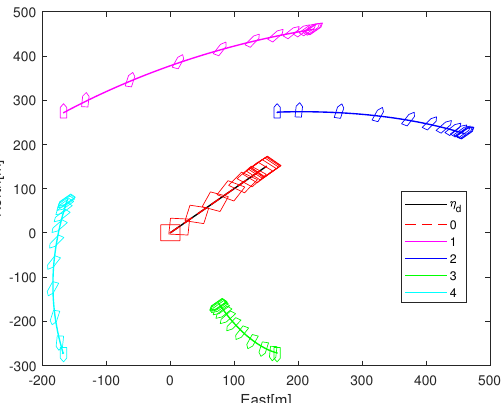
Figure 3. Trajectories of the platform and four vessels using proposed control method.